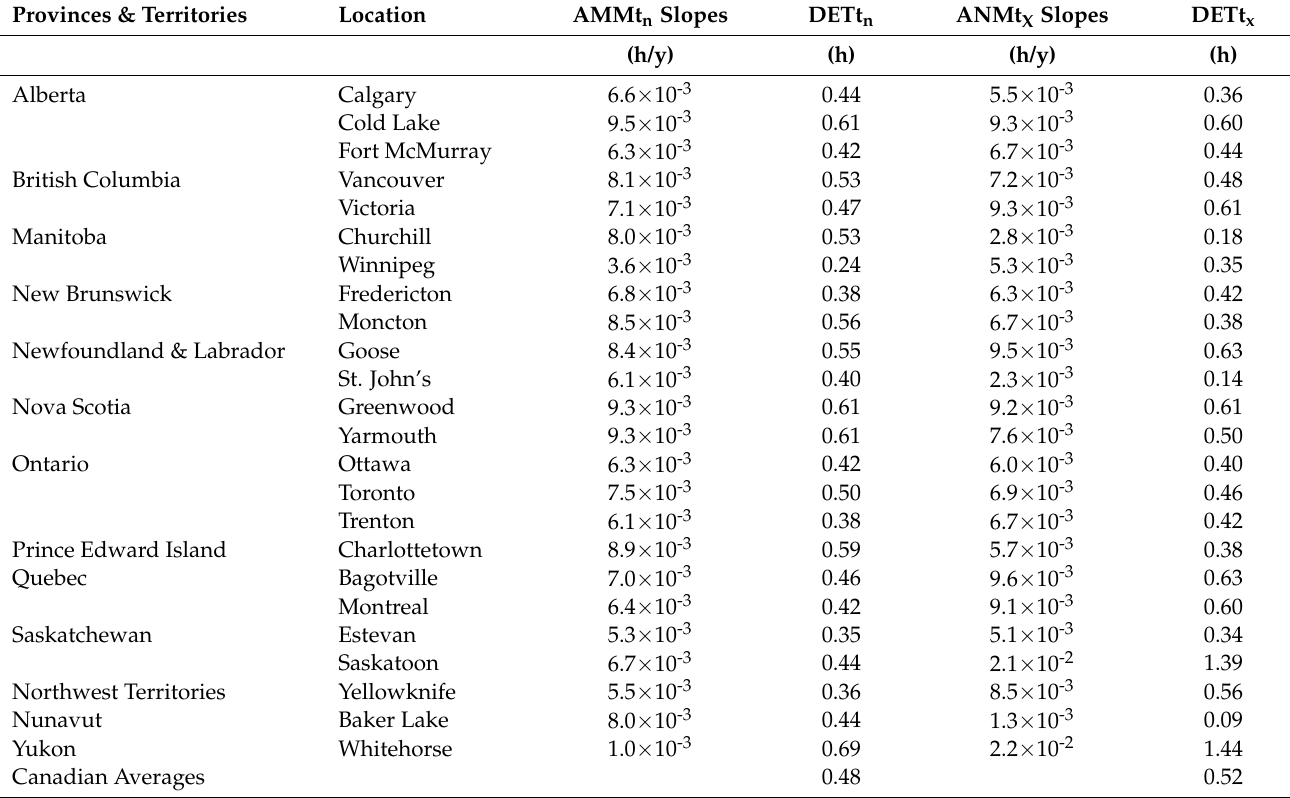
Table 5. Annually averaged timing trends of the After Midnight Minima (AMMt n ) and After Noon Maxima (ANMt x ) subpopulations and linearly projected time shifts (DETt n and DETt x ) calculated as the product of the linear slope and the time span of the study